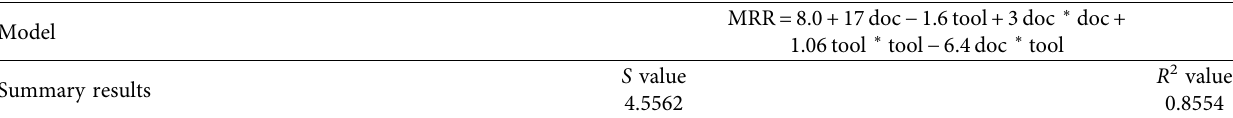
Figure 5: (a)Response surface graph for MRR (cutting speed vs. type of cutting tool). (b)Contour surface plot for MRR (cutting speed vs. type of cutting tool). Table 10: Regression model and summary results for